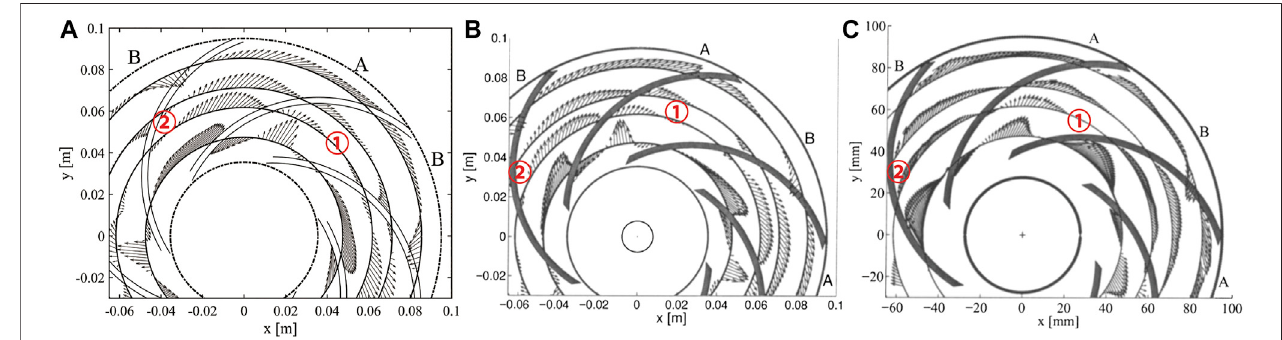
FIGURE 15 | Velocity vector distributions in the impeller mid-height at different radial positions: (A) PANS, (B) LES, and (C) LDV.